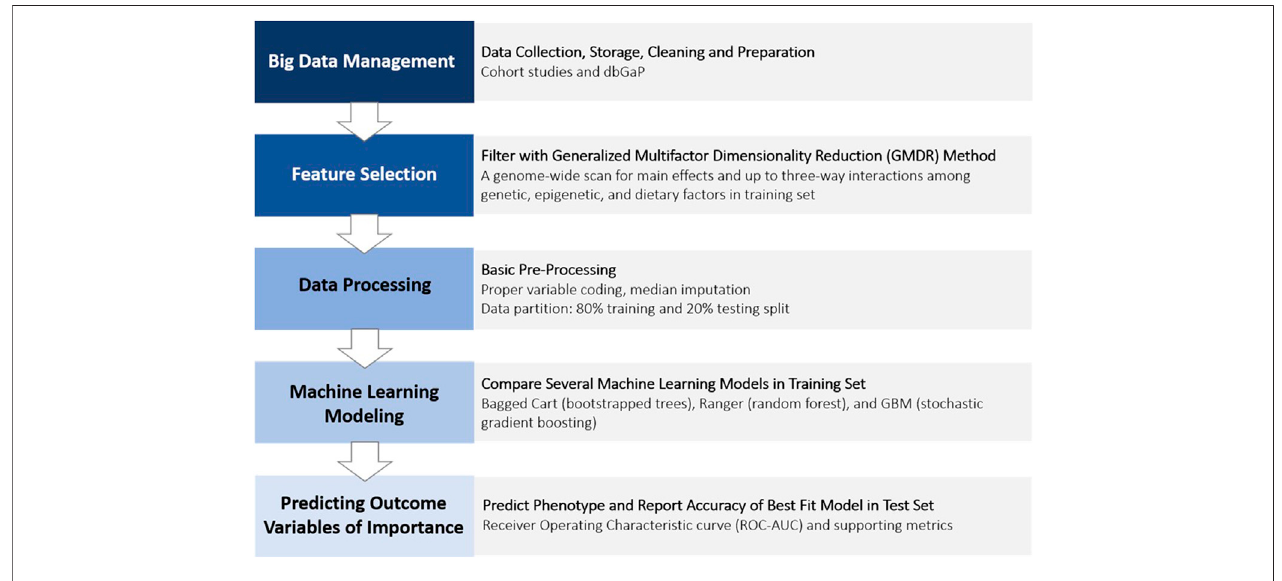
FIGURE 1 | Phenotype prediction data analysis procedure